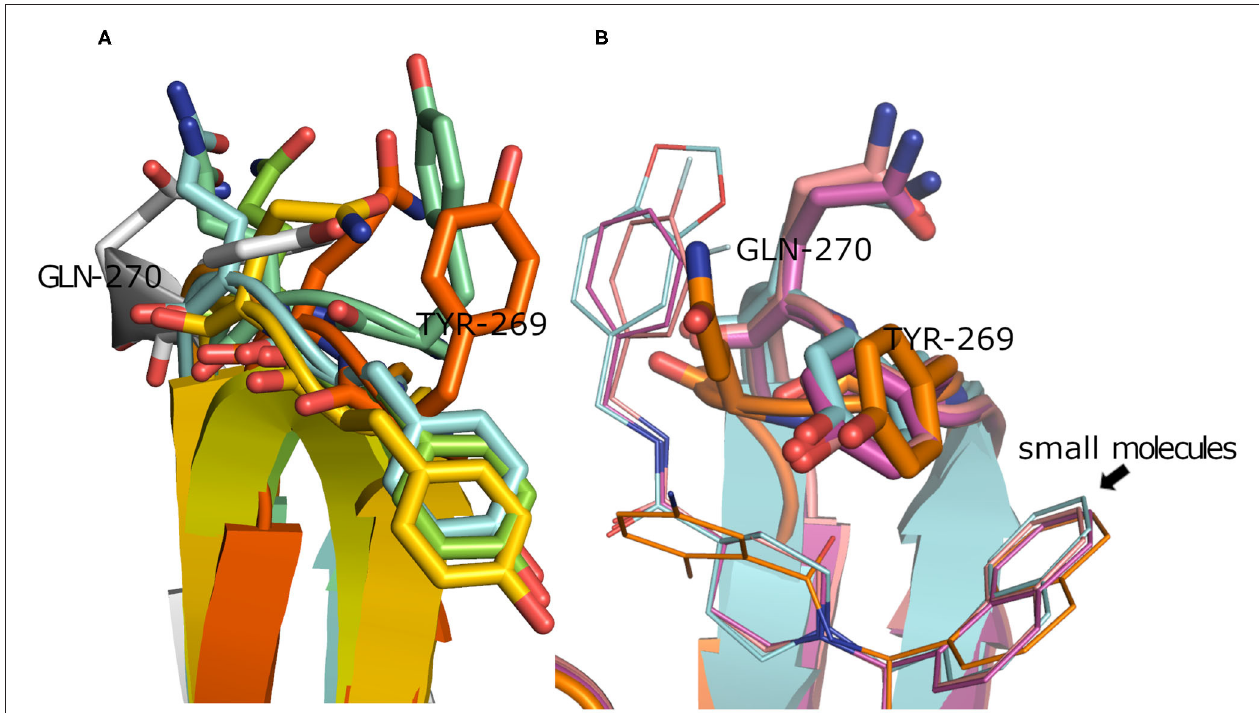
FIGURE 3 | (A) Superposition of the SARS-CoV PLpro apo structures for PDB ID: 4M0W (Chou et al., 2014), 4MM3 (Ratia et al., 2014), 5E6J (Bekes et al., 2016), 5TL6 (Daczkowski et al., 2017), 5TL7 (Daczkowski et al., 2017), 5Y3Q (Lin et al., 2018) (conjugated with beta-mercaptoethanol), and 2FE8 (Ratia et al., 2006) as cyan, pale blue, green, yellow, orange, dark orange, and gray cartoon representation, respectively, showing vast conformations of Tyr269 and Gln270 residues. (B) Superposition of the SARS-CoV PLpro co-crystal structures with small molecules for PDB ID: 3MJ5 (Ghosh et al., 2010), 4OVZ (Baez-Santos et al., 2014), 4OW0 ( Baez-Santos et al., 2014), and 3E9S as cyan, pale violet, purple, and gold cartoon representation, respectively, exhibiting more ordered conformations of Tyr269 and Gln270